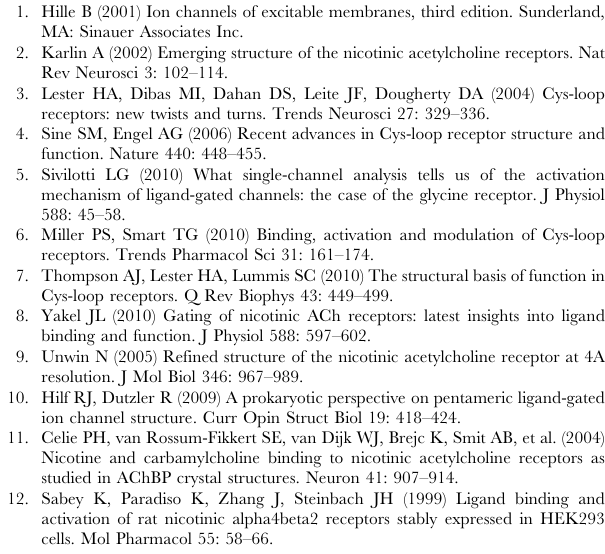
is indicated ( N ). WT is shown for comparison. The data presented in panels (A–B) are averages from at least 5 oocytes; errors are SD. The solid lines show fits to a Hill equation. Currents were recorded at 2 40 mV. (JPG) Figure S6 Ca 2 + inhibition measured from BAPTA-AM-treated oocytes. Dose–response relationships of WT activated by cyste- amine at different concentrations of Ca 2 + are shown. To chelate intracellular Ca 2 + , oocytes were incubated in solutions lacking divalent ions but containing 10 m M Bapta-AM. (C) Schild plots comparing the inhibition of ELIC in BAPTA-treated oocytes by Ca 2 + . EC 50 values were obtained from data shown in panel (A). Potencies of the antagonists (pA values) were obtained by linear regression; the intersection with the x -axis is indicated ( N ). WT from oocytes treated by standard procedures is shown for comparison. The data presented in panel (A) are averages from at least 5 oocytes; errors are SD. The solid lines show fits to a Hill equation. Currents were recorded at 2 40 mV. Table S1 Dose–response relationships of agonists in the presence of different modulators. Text S1 Supplementary